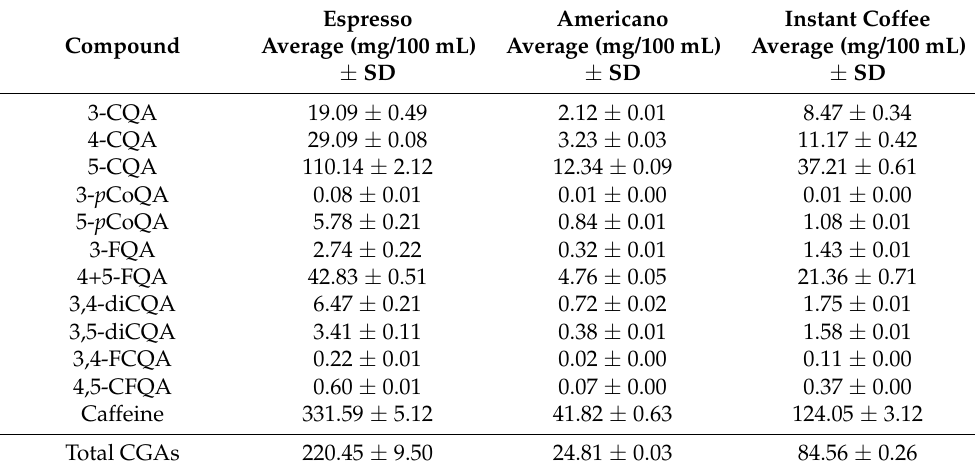
Table 2. Chlorogenic acids (CGAs) and caffeine content in the analyzed coffee brew samples. Results expressed as the average value ± standard deviation. Differences between groups were statistically analyzed with Tukey’s test; p < 0.05 was considered significant. Espresso Americano Instant Coffee Compound Average (mg/100 mL) Average (mg/100 mL) Average (mg/100 mL) ± SD ± SD ± SD 3-CQA 19.09 ±